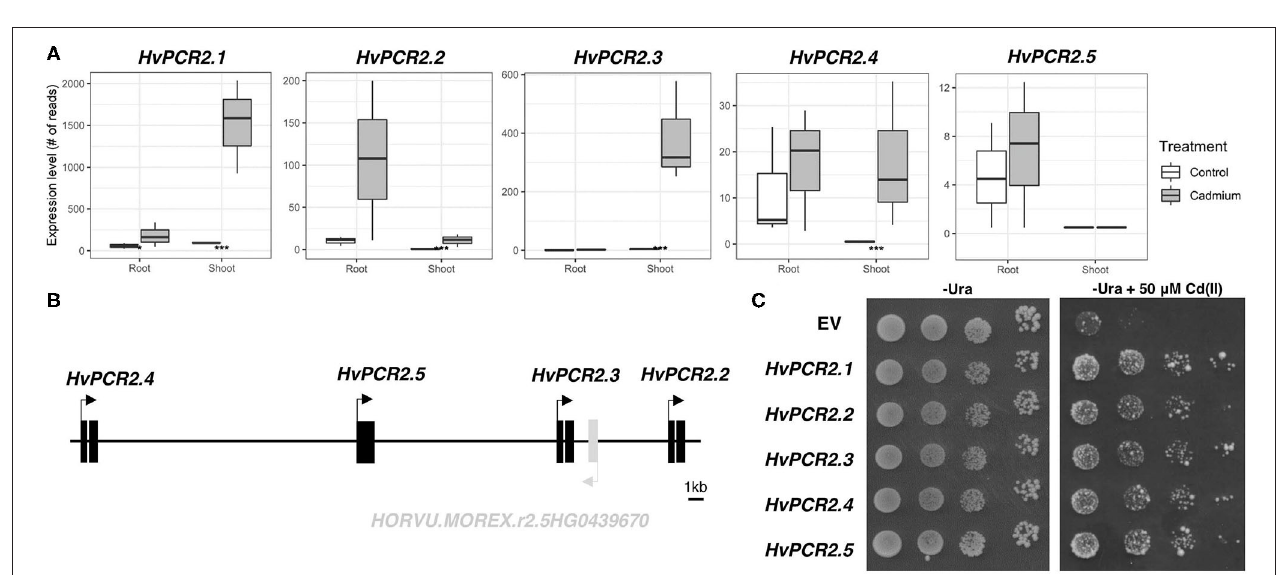
FIGURE 5 | Ten most abundant gene ontology of differentially expressed genes present in roots and shoots. The 10 most abundant biological process, molecular function, and cellular component gene ontology (GO) are displayed for both root and shoot tissues.